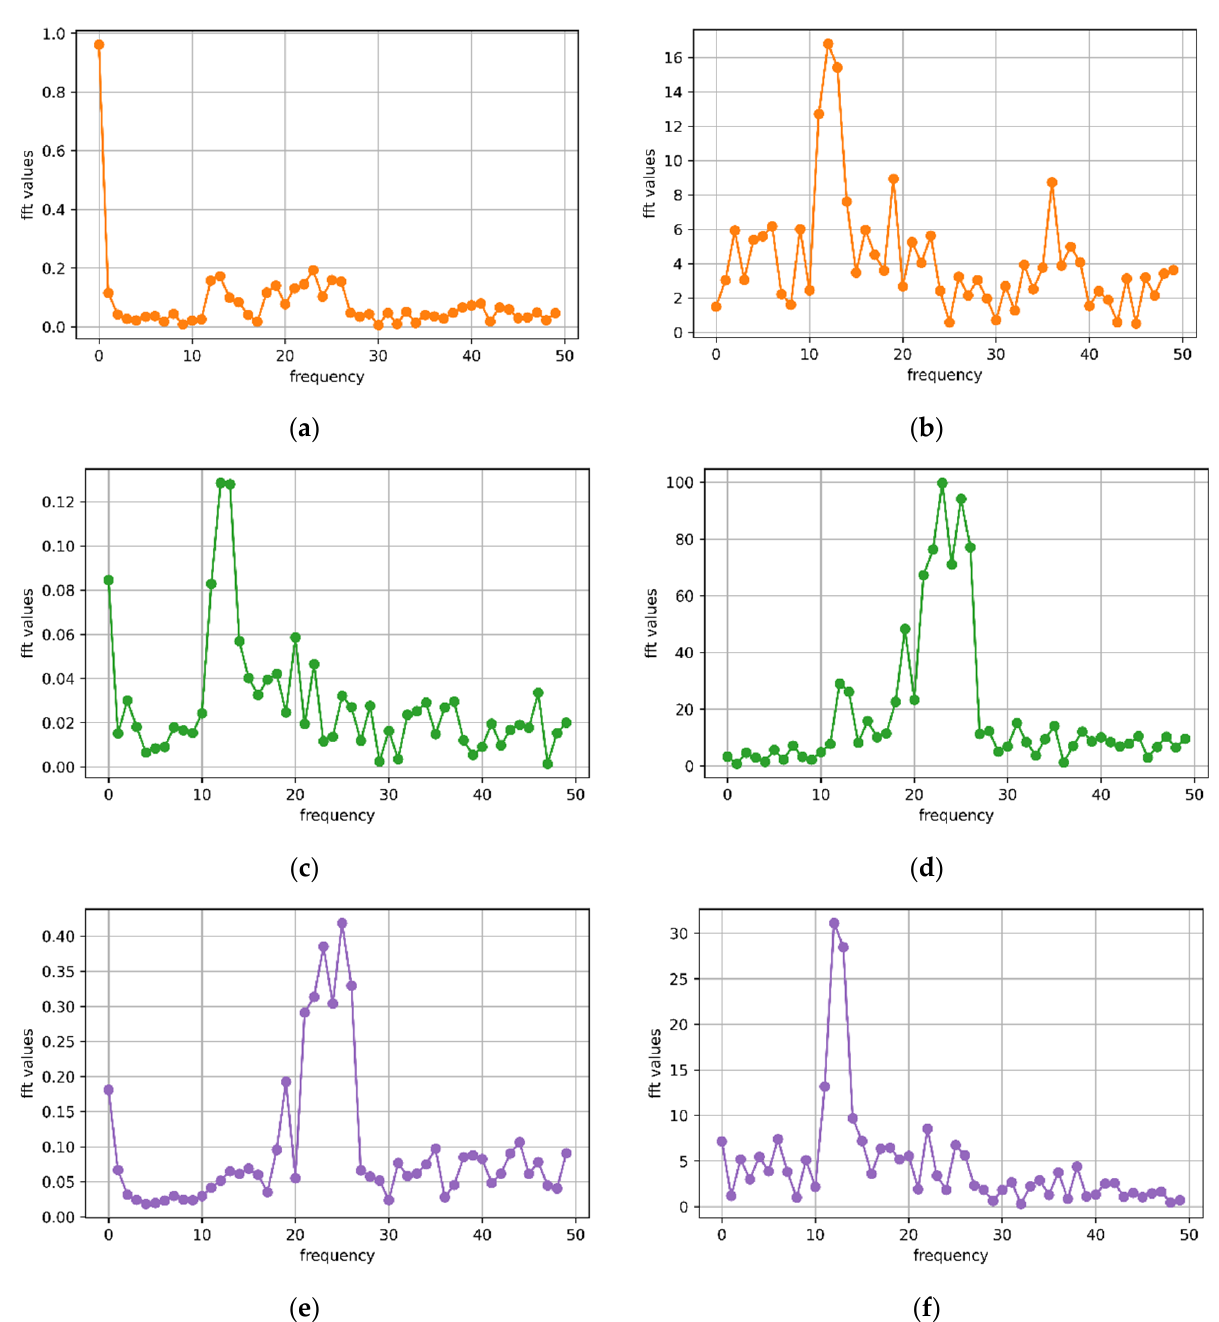
Figure 7. Fourier transform analysis of three-axis accelerometer and three-axis gyroscope signals for 5 s of running behavior, as shown in Figure 6, calculating the main frequency and period. ( a ) x -axis accelerometer: n = 23; N = 100; f = 4.4 Hz; T ≈ 0.23 s; ( b ) x -axis gyroscope: n = 12; N = 100; f = 2.2 Hz; T ≈ 0.45 s; ( c ) y -axis accelerometer: n = 12; N = 100; f = 2.2 Hz; T ≈ 0.45 s; ( d ) y -axis gyroscope: n = 23;